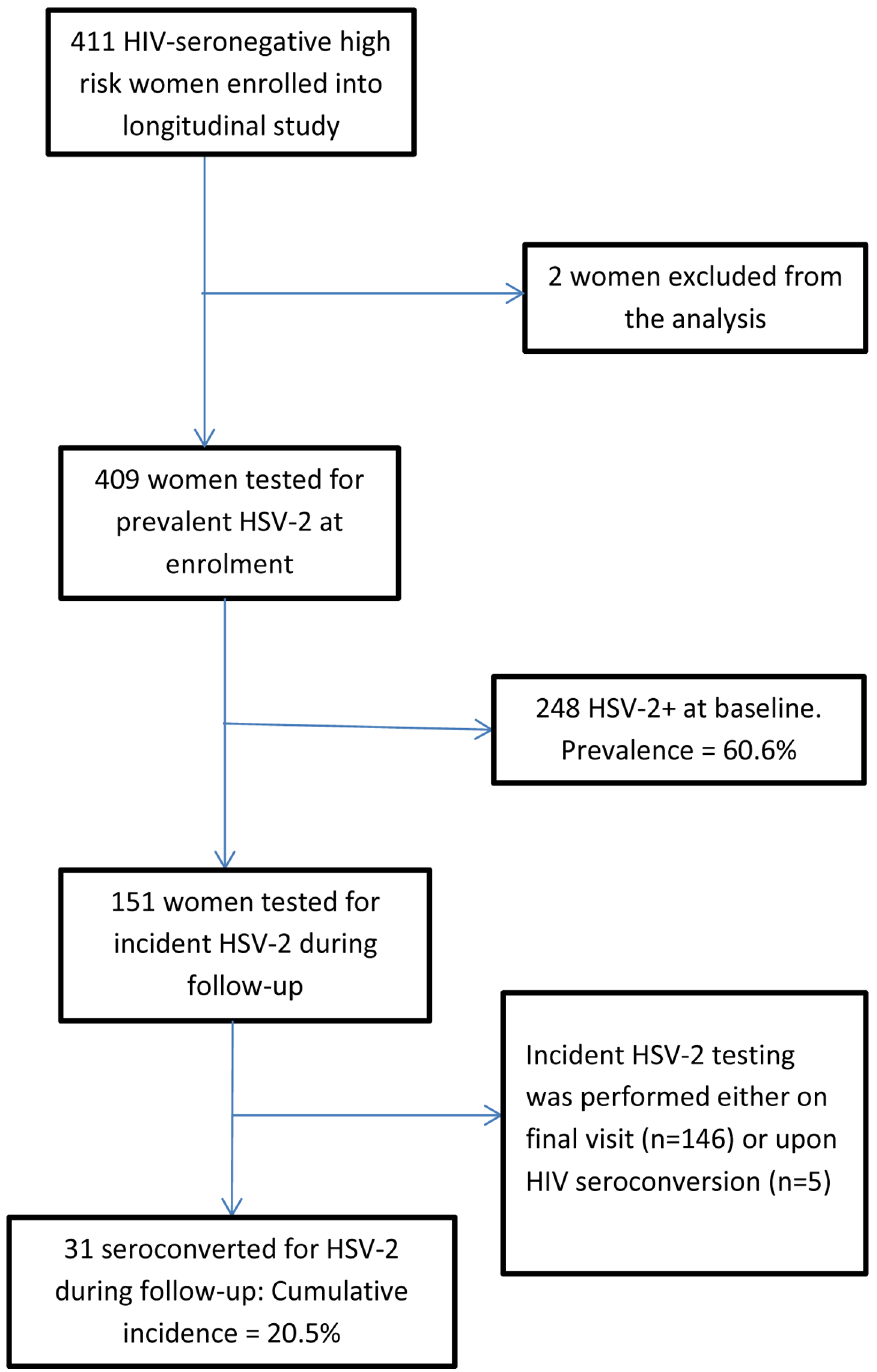
Figure 1. Participant flow diagram describing numbers enrolled, numbers tested for HSV-2 prevalence, and numbers included for HSV-2 incidence. doi:10.1371/journal.pone.0089705.g001 in two subgroups: demographic/socioeconomic factors and sexual behavioral factors. All factors associated with HSV-2 infection at p # 0.20 in the bivariable analyses were included in explanatory multivariable logistic regression models. The first multivariable model included demographic/socioeconomic factors only (Model I) and the second model sexual behavior factors only (with age forced into the model due to its importance as a confounder: